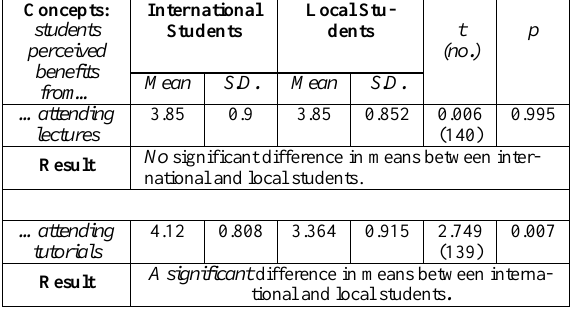
TABLE IV. SCQ SURVEY RESPONSES FOR PERCEIVED BENEFITS OF INTERVENTION AND ENHANCEMENT OF TUTORIALS